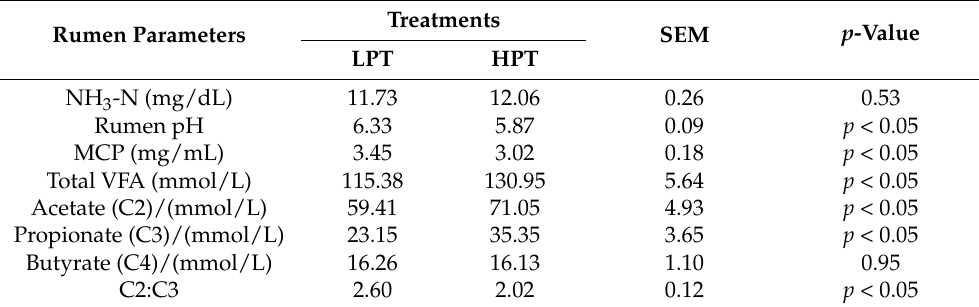
Table 6. Effects of low and high NFC to NDF ratio pelleted TMR on rumen fermentation parameters in Holstein growing